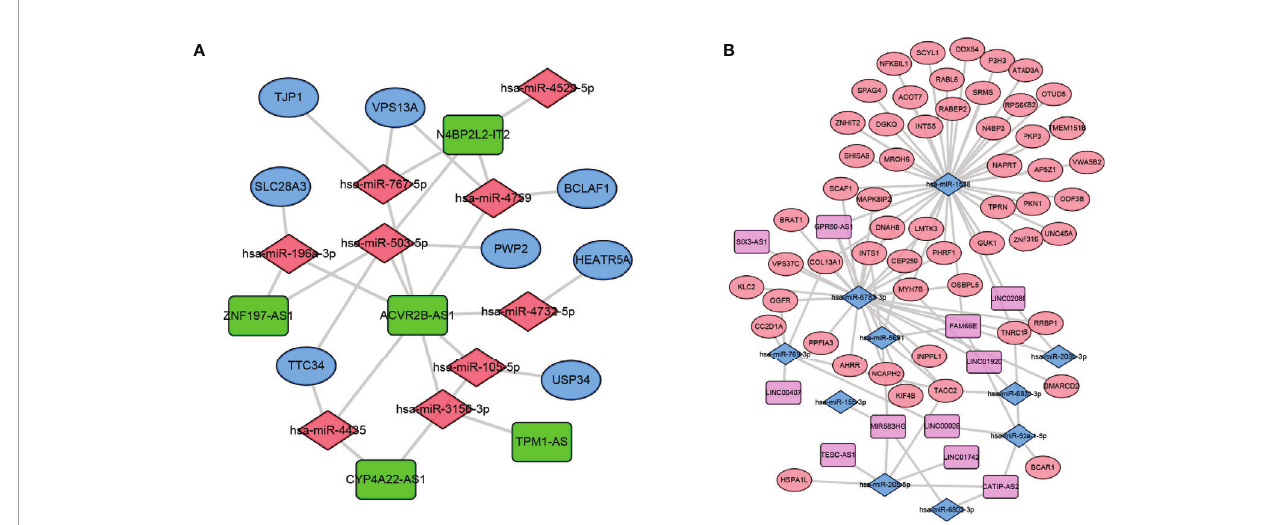
FIGURE 3 | Construction of the metastasis associated ceRNA networks. Upregulated miRNAs ceRNA network (A) and downregulated miRNAs ceRNA network (B) . In network A, orange diamond: upregulated miRNAs, green rectangle: downregulated lncRNAs, Blue Oval: downregulated mRNAs. In network B, orange oval: upregulated mRNAs, pink rectangle: upregulated lncRNAs, blue diamond: downregulated